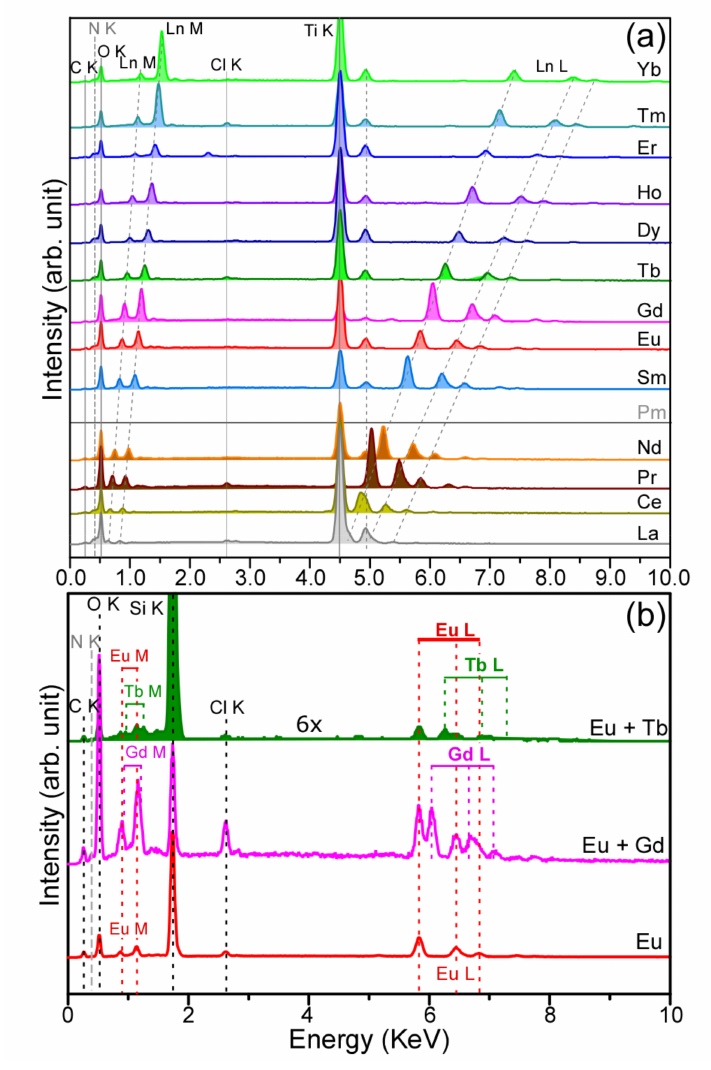
Figure 3. EDXS (energy dispersive X-ray spectroscopy) profiles of electrodeposited Ln ( a ) and electrodeposited Eu ( b , red line), Eu + Gd ( b , pink line), and Eu + Tb ( b , green shaded line) on TiNS-SiTpy electrodes. Si K signal was due to Si substrate for mounting electrodeposited